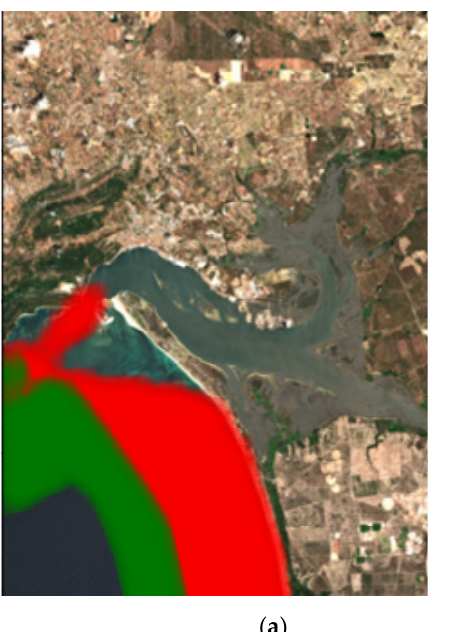
Figure 14. ( a ) Neural Network Prediction; ( b ) final decision considering land use data.